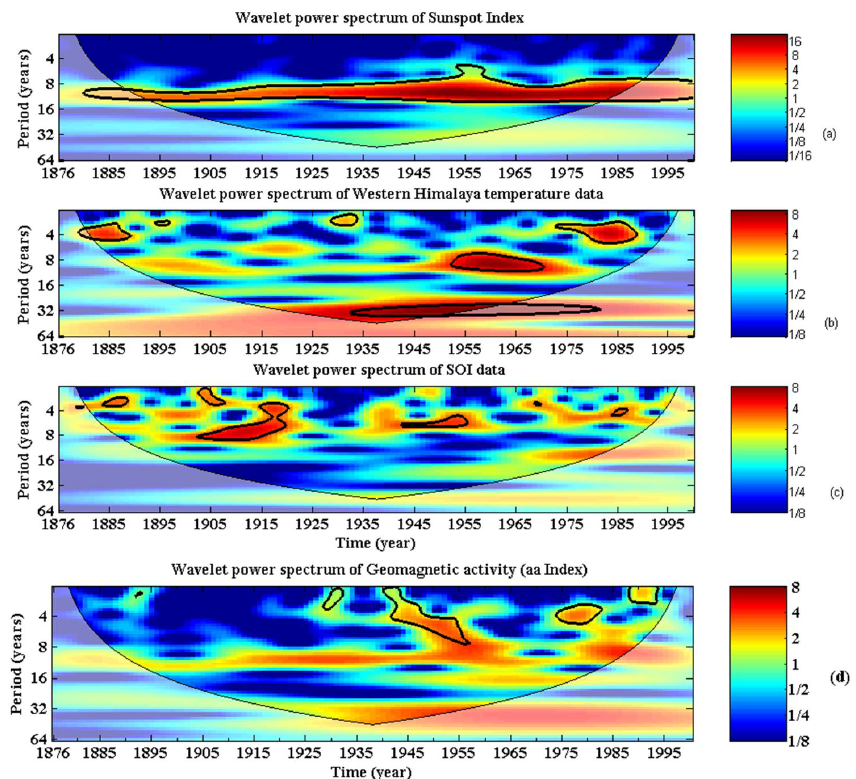
Figure 4. Wavelet power spectrum of (a) sunspot number, (b) Western Himalayan temperature data, (c) Southern Oscillation Index (SOI) and (d) geomagnetic activity (aa indices) with the cone of influence (lighter shaded smooth curve) and black lines indicating significant power on the 95% level compared to red noise based on the first-order auto-regressive (AR(1)) coefficient. The legend on the right indicates the cross-wavelet